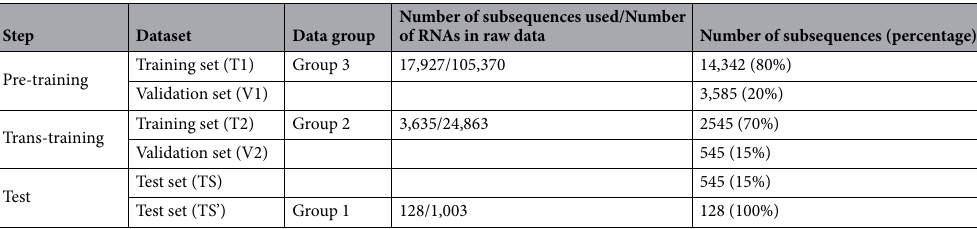
Table 1. Data and datasets. a Percentage to the corresponding group (group 1,2 or 3).